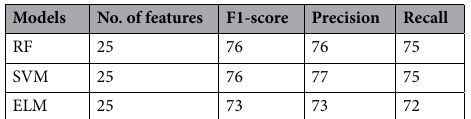
Table 3. Performance of SVM, random forest and ELM with feature selection using tenfold CV.